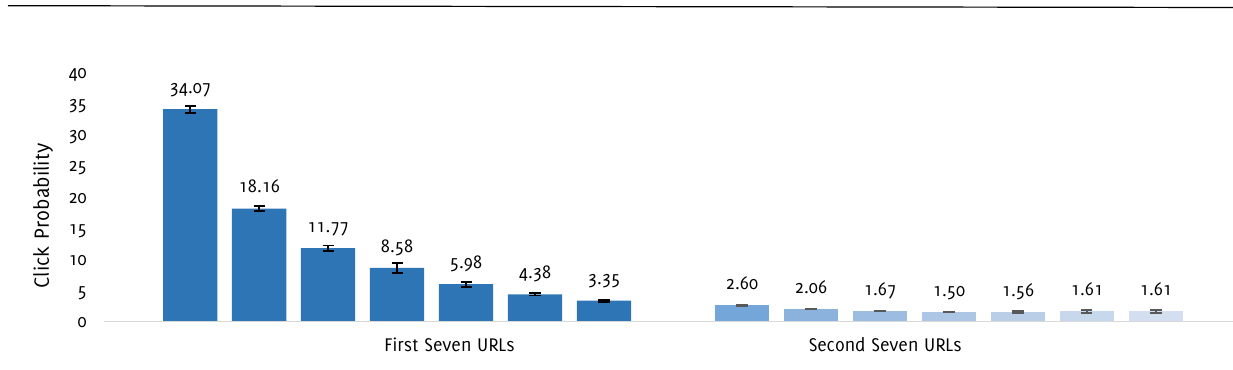
Figure 1 . Probability of Clicks Occurring in the First Seven URLs vs. The Following Seven URLs of a 2019 Google Search, A Total of Fourteen URLs Are Shown with a Cumulative CTR Value of 98.90, Error Bars Represent Standard Deviation Based on Monthly Data from 2019.